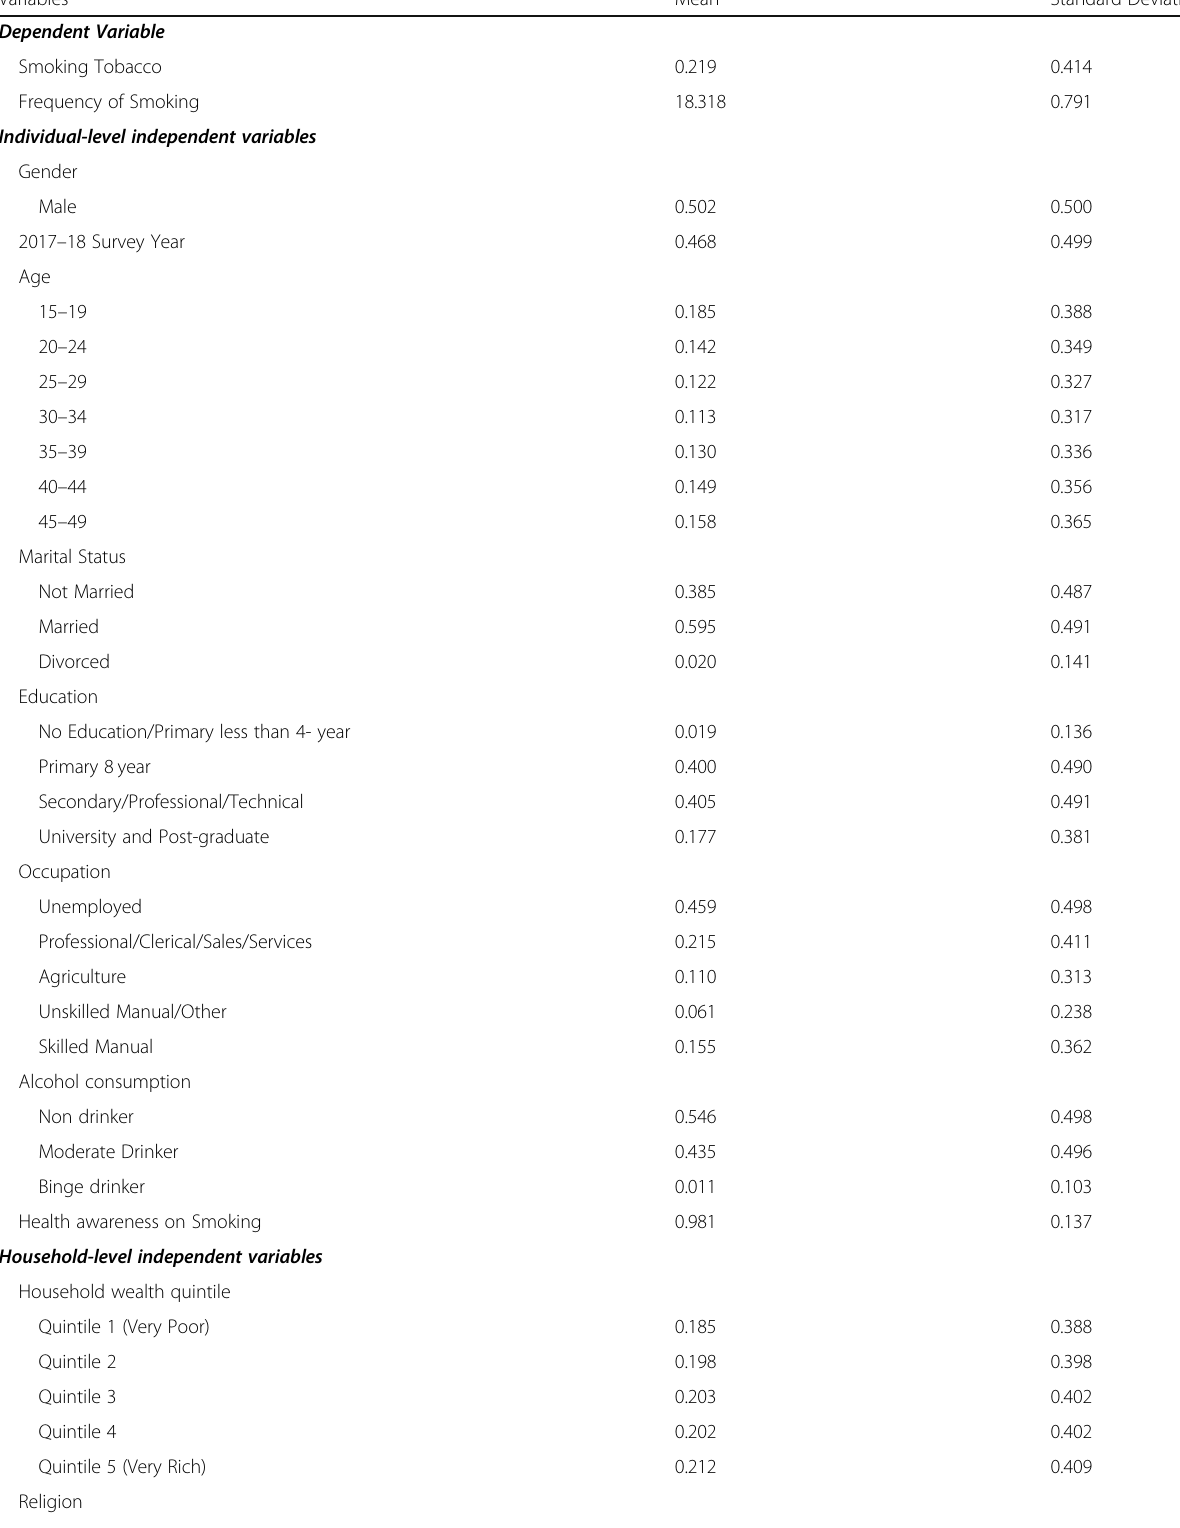
Table 1 Summary Statistics for the dependent and independent variables ( N =